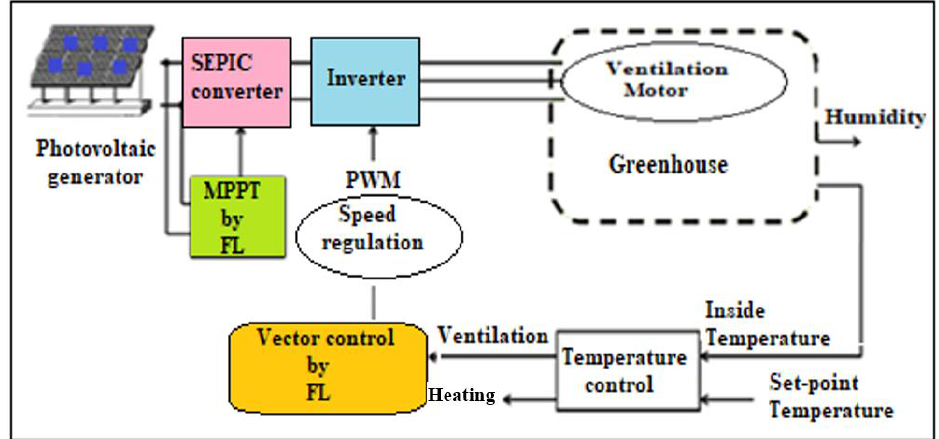
Figure 18. Photovoltaic (PV)-based ventilation system.